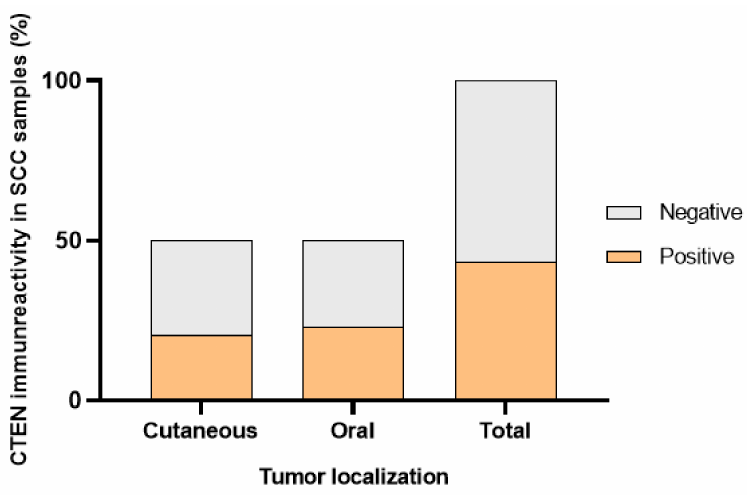
Figure 5. CTEN immunoreactivity in cutaneous and oral